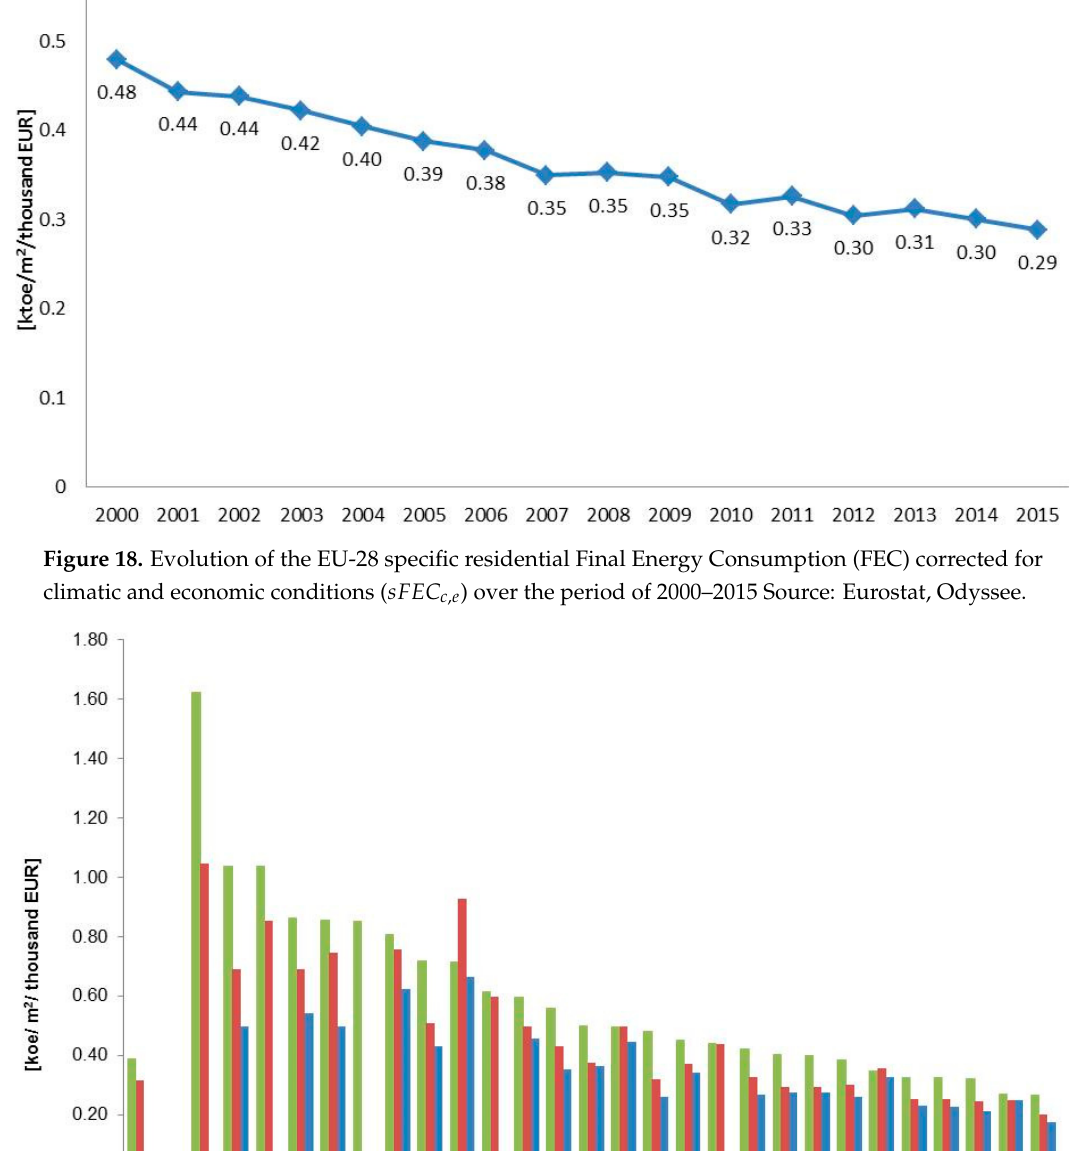
Figure 18. Evolution of the EU-28 specific residential Final Energy Consumption (FEC) corrected for climatic and economic conditions ( 𝑠𝐹𝐸𝐶 (cid:3030),(cid:3032) ) over the period of 2000–2015 Source: Eurostat, Odyssee.